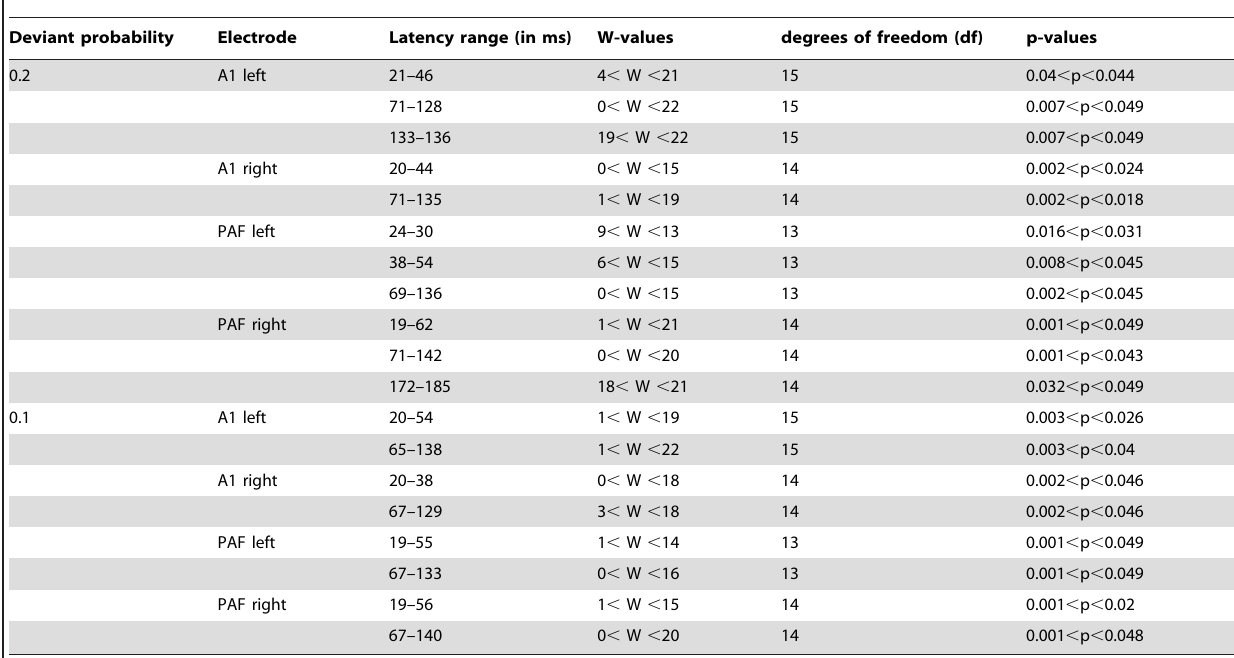
Table 2. Significant differences between standard and deviant deflections with respect to deviant probability.